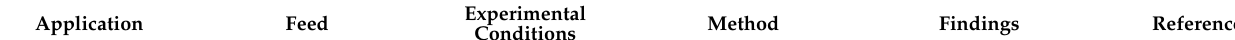
Table 3. Comparison studies between microwave-assisted technologies and conventional